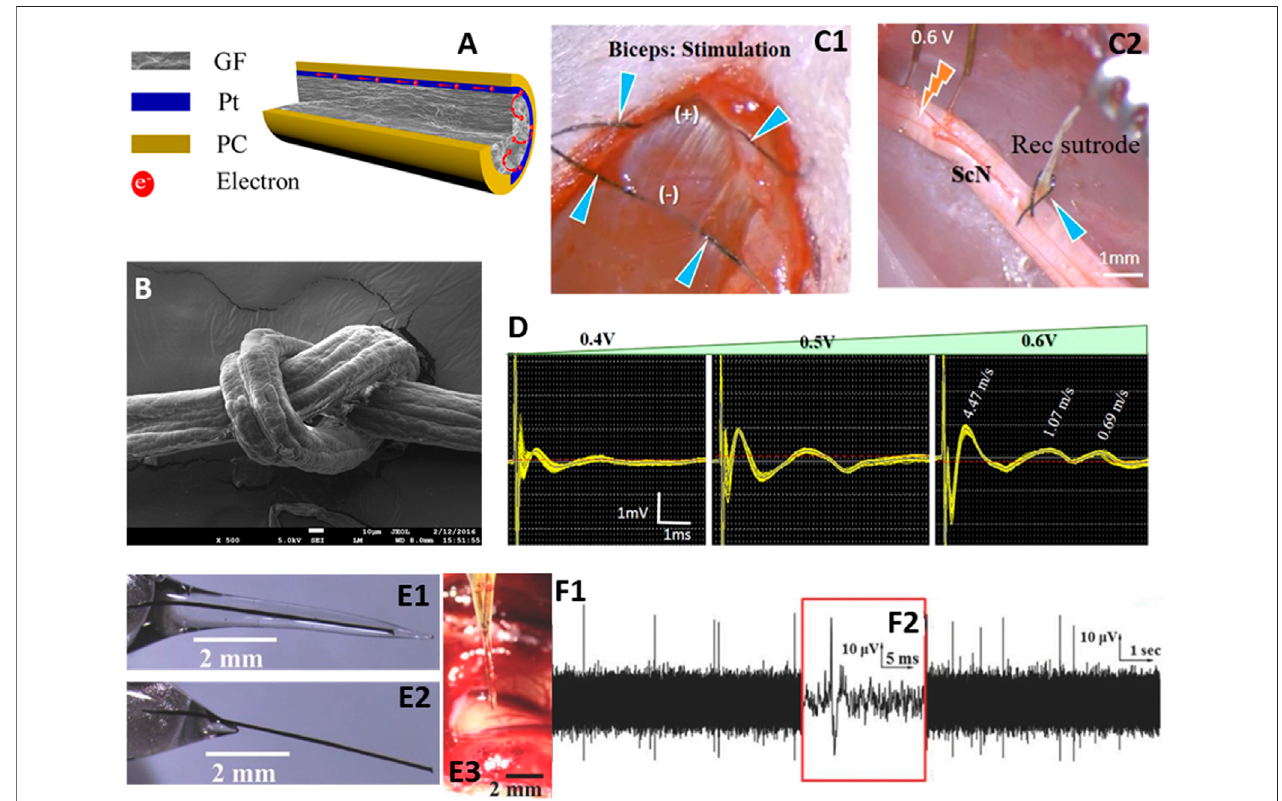
FIGURE 1 | (A) structure of graphene micro fi ber electrode -sutrode, (B) SEM image of sutrode tied into a knot, (C1) Sutrode placed on biceps (blue arrows), (C2) Stimulation of the tibial nerve fascicle with hook electrodes and recording with the sutrode (blue arrow), (D) recording of graded evoked compound nerve action potentials, (E1) Graphene fi ber encased in sucrose microneedle, (E2) sutrode after the sucrose microneedles are dissolved, (E3) sucrose microneedle coated sutrode insertedintofelinevisualcortex,(F1)neuralactivityrecordedwithin20 sofimplantation,con fi rmingsucrosedissolution,and(F2)magni fi edimageofactionpotential recorded with sutrode. Adapted with permission from (Apollo et al., 2015; Wang et al., 2019; Gonzalez-Gonzalez et al., 2021).